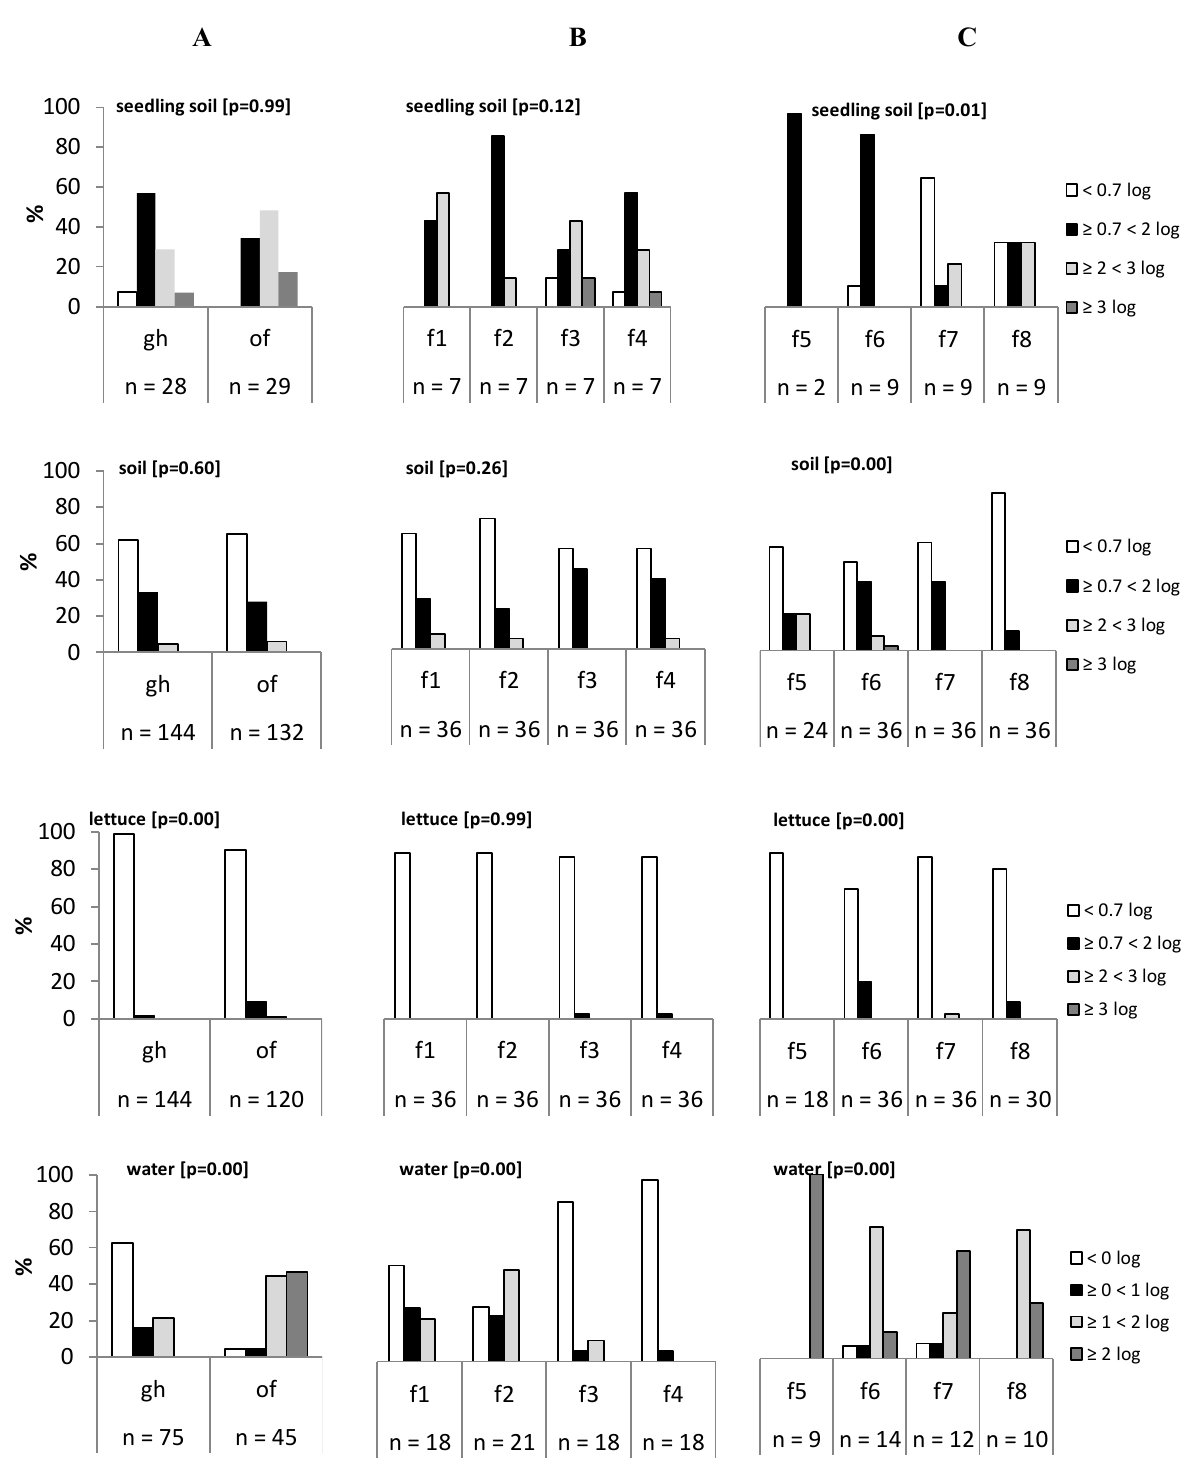
Figure 3. ( A ) Comparison of E. coli distribution between greenhouse farms (gh) and open field farms (of) for seedling soil, mature plant soil, lettuce, and water. ( B ) Comparison of E. coli distribution between individual greenhouse farms (f1, f2, f3, f4). ( C ) Comparison of E. coli distribution between individual open field farms (f5, f6, f7, f8). The P-value is shown after the